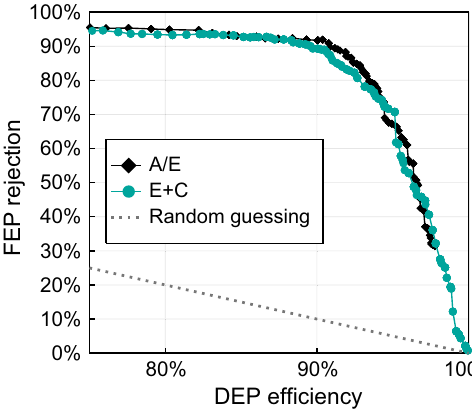
Fig. 9 Rejection power of the combined encoder+classifier network (E + C) compared to the A / E discrimination algorithm